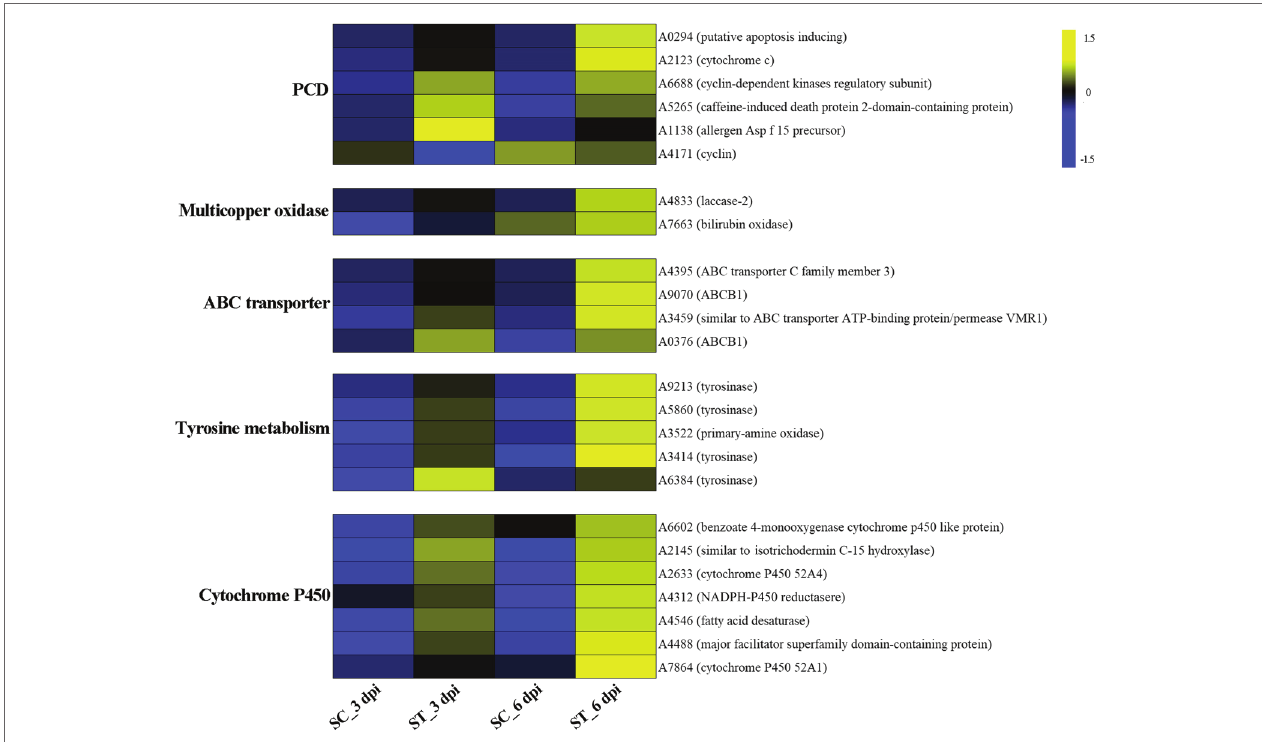
FIGURE 7 | Heat map of DEGs that responded to P. penicillatus infection in M. sextelata . PCD, programmed cell death; ST and SC represent the inoculated and non-inoculated samples, respectively; dpi, days post-inoculation; blue indicates downregulated DEGs, while yellow indicates upregulated DEGs. KEGG, kyoto encyclopedia of genes and